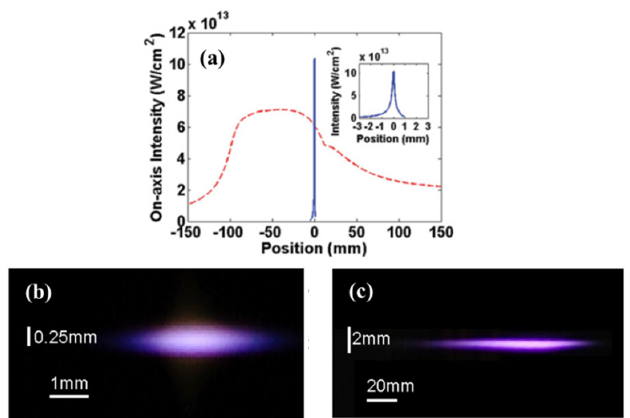
Figure 8. ( a ) Optical intensity distribution generated by SSTF pulses (blue solid line) and conventionally-focused laser pulses (red dashed line). Filament profiles generated by ( b ) the SSTF scheme; and ( c ) the conventional focusing scheme. Reproduced with permission from [21], Copyright American Physics Society, 2011.